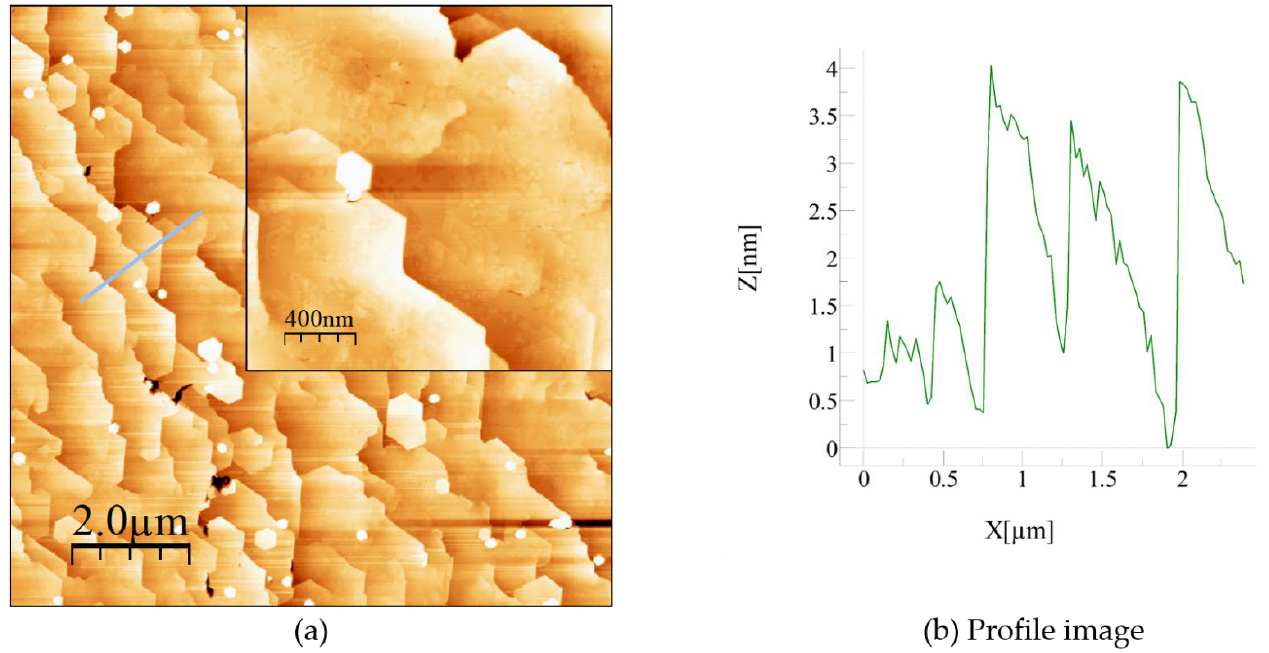
Figure 6. Atomic force microscopy images of sample C, a 220 nm thick AlN epilayer grown on annealed sample B. ( a ) (10 × 10) µ m 2 image with an RMS = 1.7 nm, the inset showing (2 × 2) µ m 2 scan image with an RMS = 1 nm. ( b ) Profile measurement of a specific marked zone of the (10 × 10) µ m 2 image indicated by a blue line.